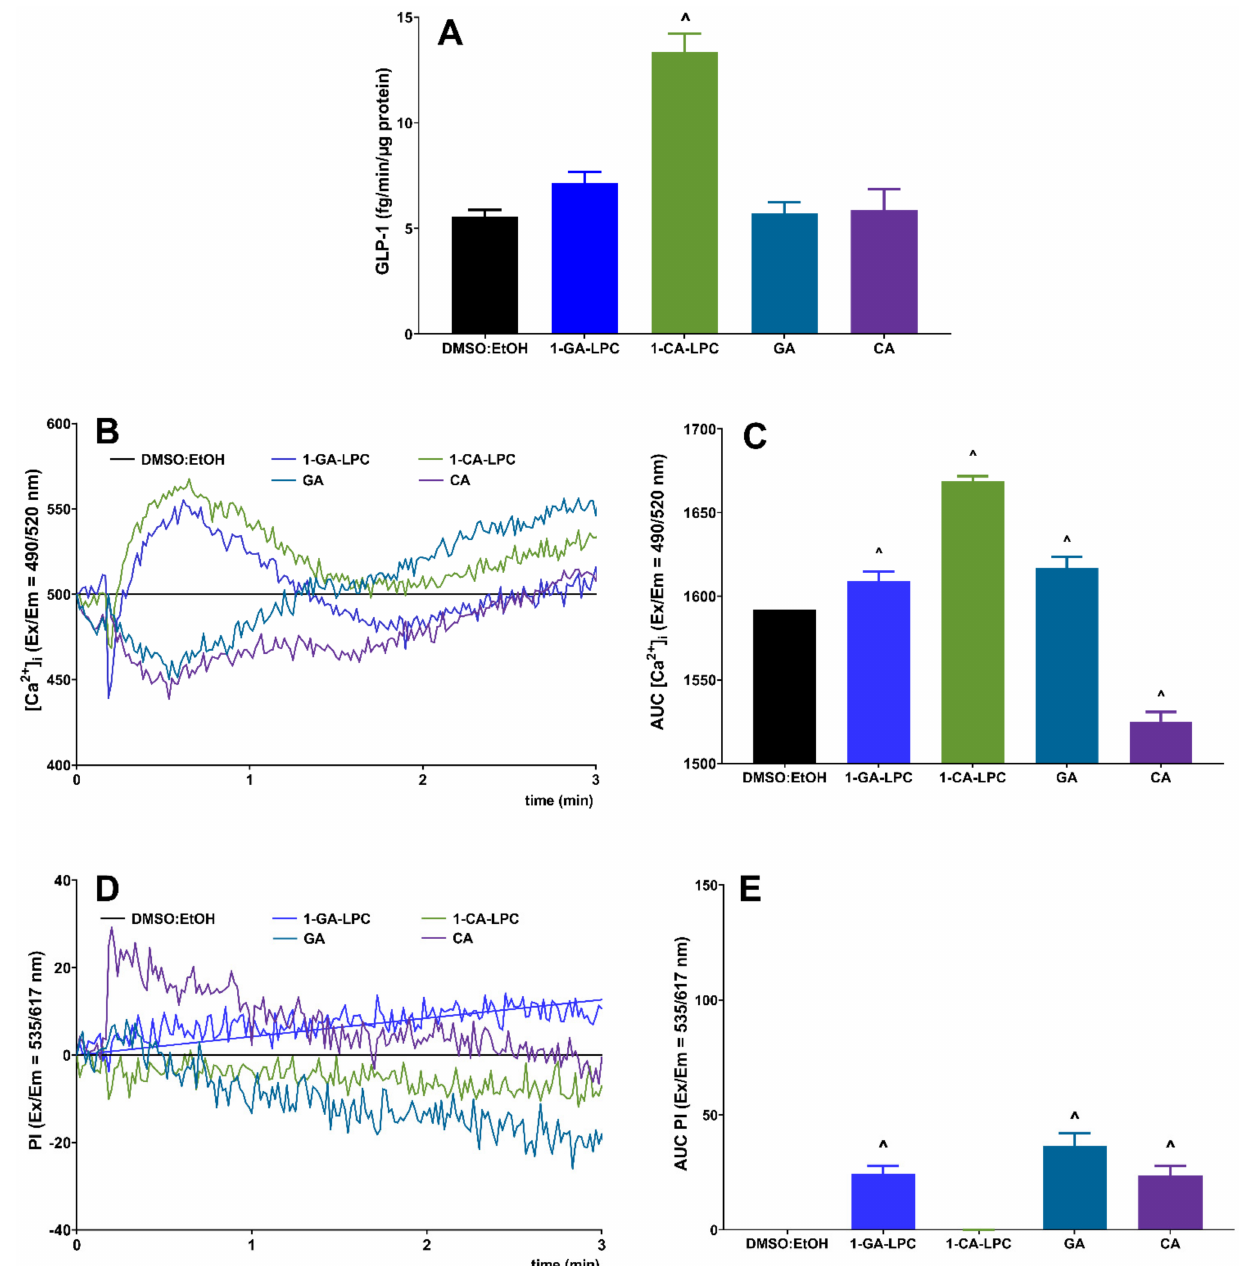
Figure 8. GLP-1 secretion ( A ) and intracellular Ca 2+ mobilization ( B , C ) with simultaneous monitoring of membrane integrity via PI incorporation ( D , E ) in GLUTag cells stimulated with 10 µ M 1-GA-LPC, 1-CA-LPC and their corresponding acids (GA, CA). For Ca 2+ mobilization, the results are presented as the real-time kinetics of [Ca 2+ ] i and [PI] changes inside the cell during 3 min-time monitoring as well as AUC ± SEM from − 4 independent experiments, 4-6 biological replicates each. p < 0.05 for GLP-1 secretion and Ca 2+ mobilization was considered significantly different from EtOH:DMSO control